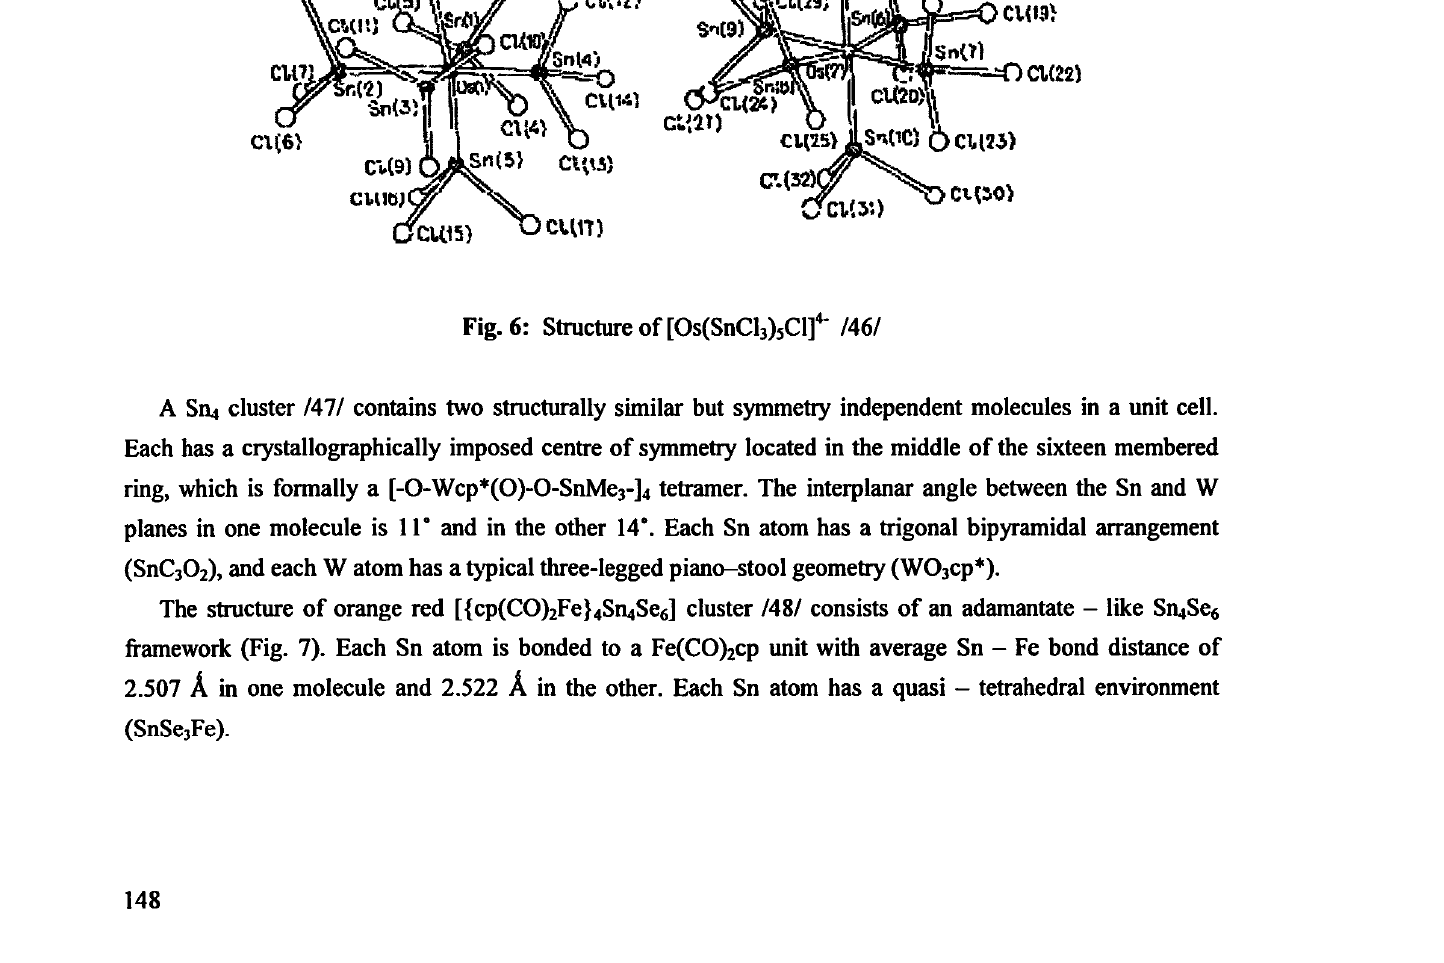
Fig. 6: Structure of [Os(SnCl